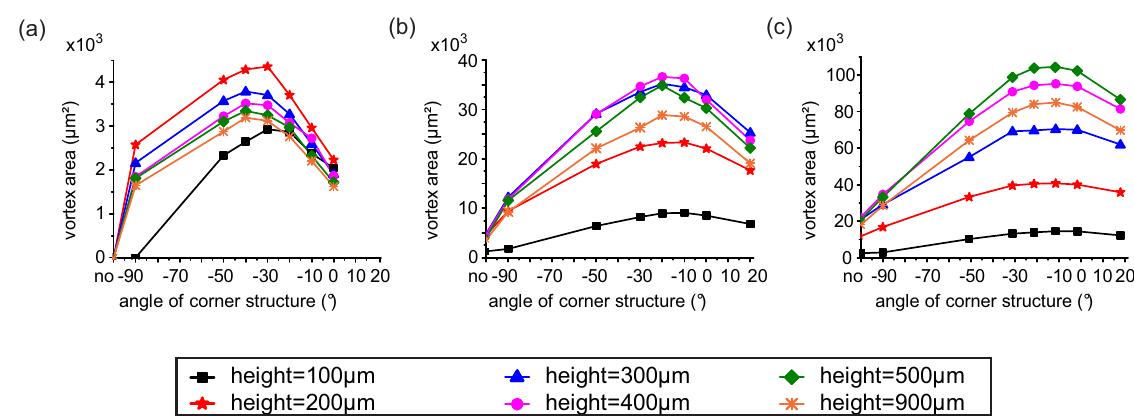
Figure 3. Microvortex area as a function of the angle of the corner structure calculated in the simulation study for different step heights and inlet volume flow rates of 100 µ L/min ( a ) 200 µ L/min ( b ) and 300 µ L/min ( c